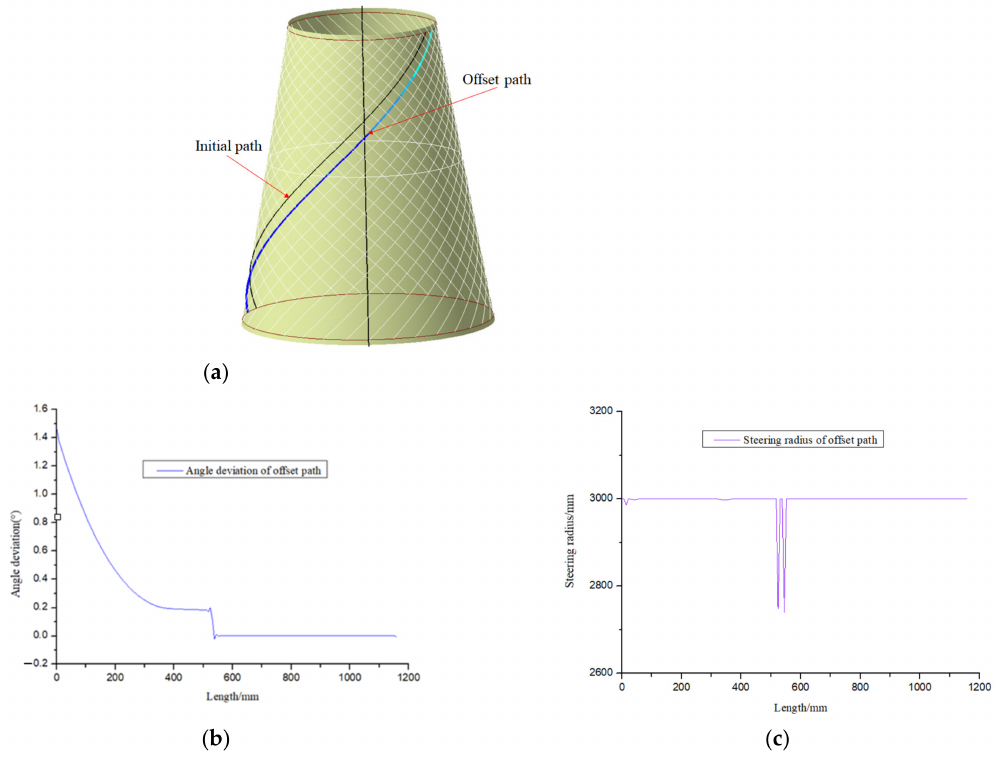
Figure 10. Circumferential averaging planning trajectory and its manufacturability. ( a ) Circumferential averaging path planning. ( b ) Angular deviation of each offset path. ( c ) Steering radius of each offset